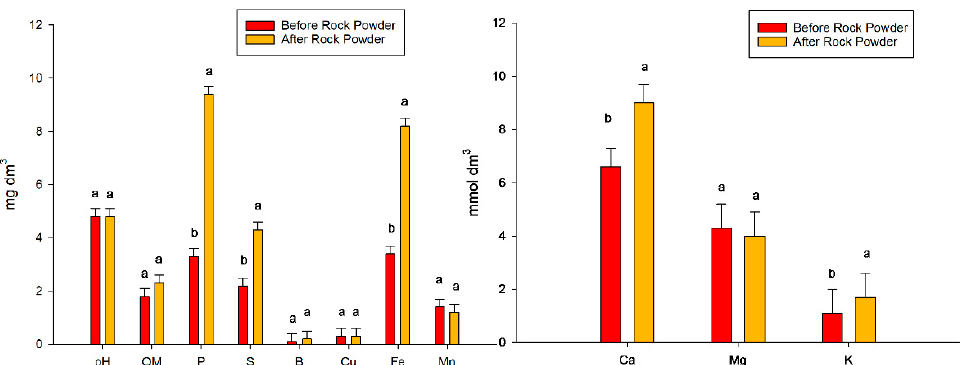
Figure 2. Chemical and physical attributes of the soil before and after the rock powder incubation process. Bars mean = standard error. Different lowercase letters mean significant statistical differ ‐ ences.